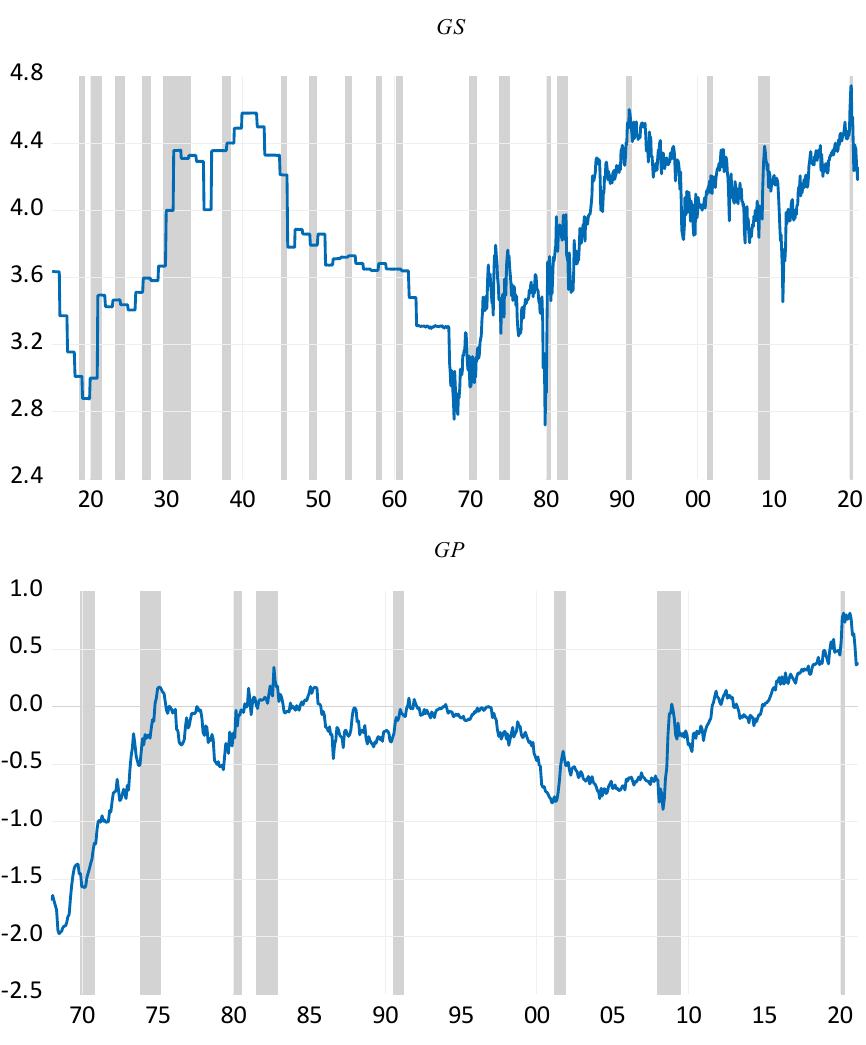
Figure A1. Data plot. Note: RV is realized variance of oil returns, with (cid:102) RV = ln(1 + RV); GS is the natural logarithm of gold-to-silver price ratio; GP is the natural logarithm of gold-to-platinum price ratio. Shaded regions correspond to NBER recession dates in the US.